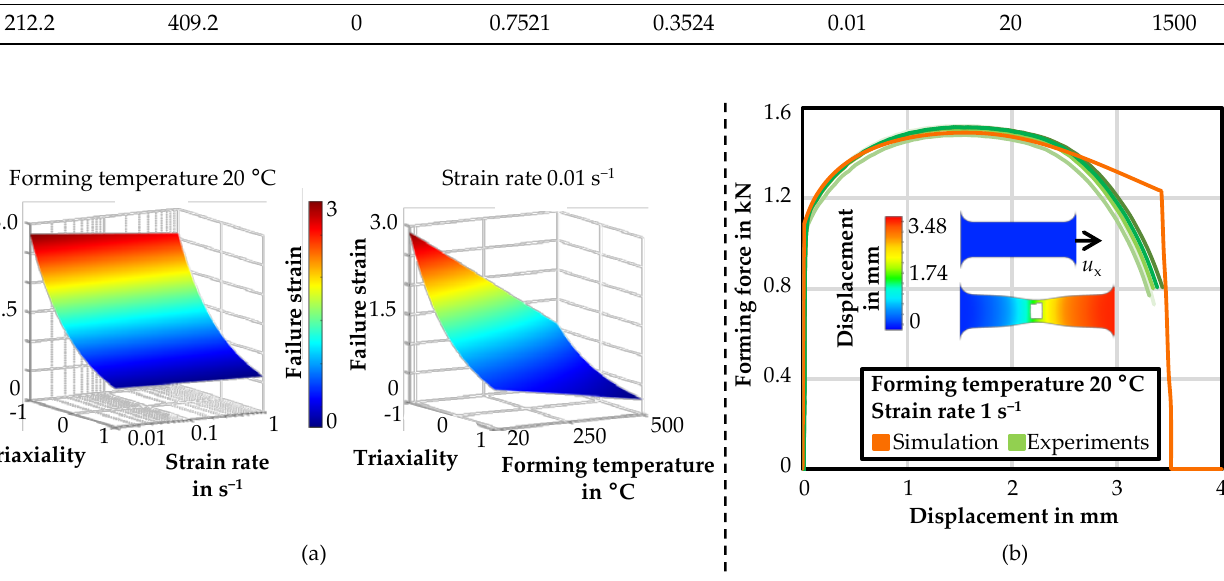
Figure 7. A 3D representation of the Johnson–Cook failure model for HX220 ( a ); and a comparison of the forming force– displacement curves from the experiments and simulation with displacement in x-direction u x ( b ).